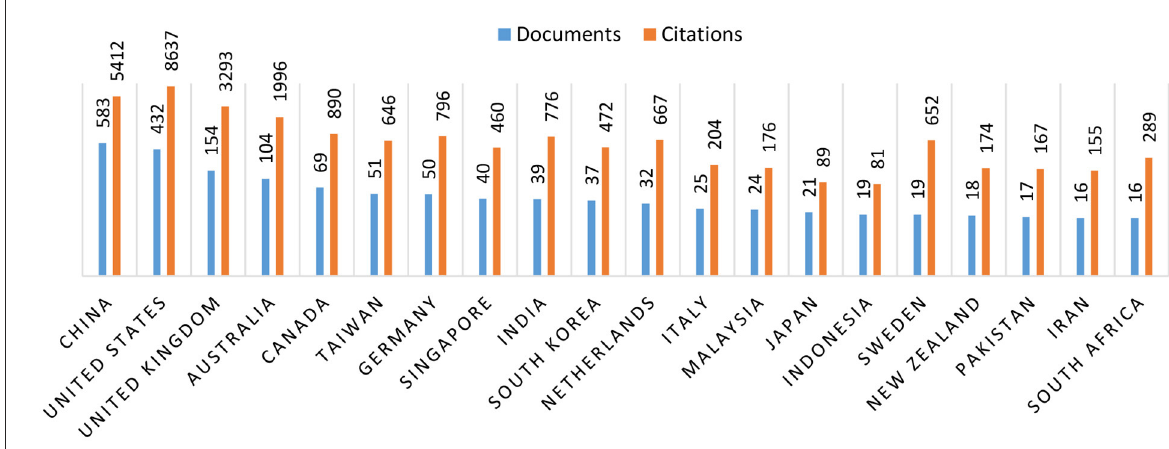
FIGURE3 Number of documents and citations published in term of country.